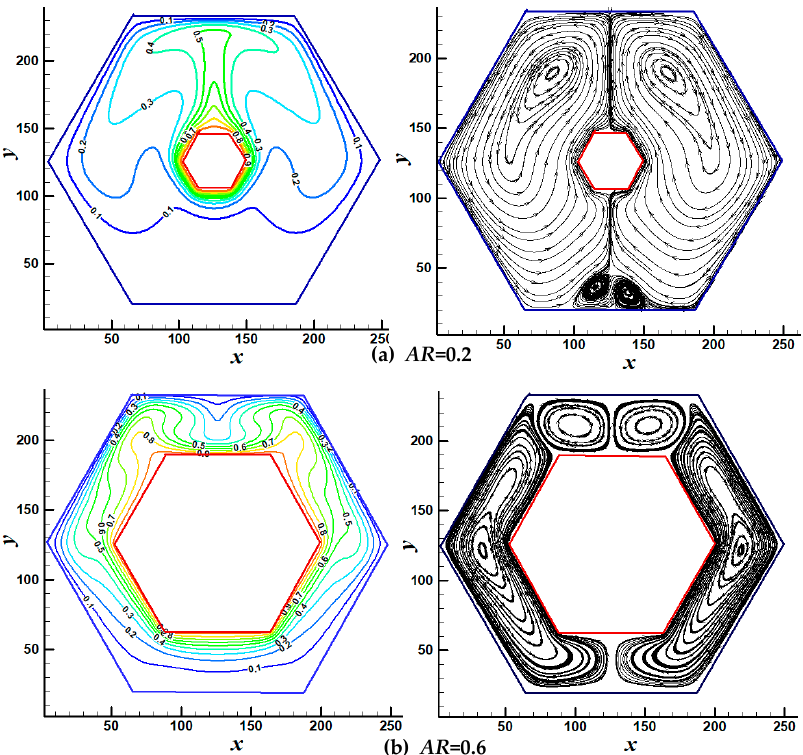
Figure 5. Isotherms (left side) and streamlines (right side) patterns inside the hexagonal annulus when the Rayleigh number is, 6 Ra 10 = , and for AR = 0.2 ( a ), and AR = 0.6 ( b